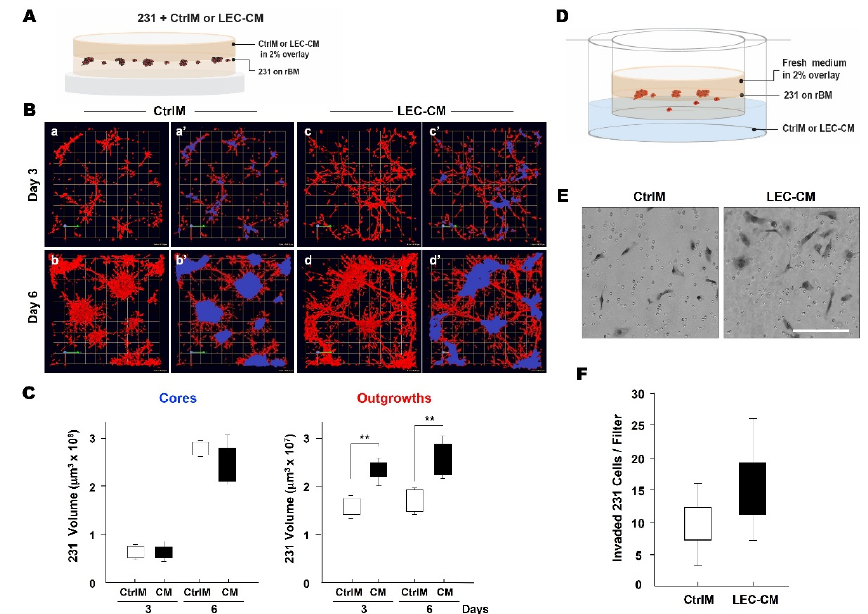
Figure 4. LEC secretome increases invasive phenotype of MDA-MB-231 spheroids. ( A ) Schematic illustrating protocol for incubation of 231 spheroids in 3D rBM overlay cultures with control media (CtrlM) or LEC MG -conditioned media (LEC-CM or CM). ( B ) En face views of representative 3D reconstructions of 231 spheroids (red) in CtrlM (a,b) or LEC-CM (c,d) at 3 and 6 days. To quantify effects on invasive phenotype, 231 spheroids were segmented as illustrated in a’–d’ into central cores (blue) and multicellular invasive outgrowths (red) using Volocity software. Images are tiled from 16 contiguous fields; each grid represents 250 µ m. ( C ) Volumes of 231 cores and multicellular invasive outgrowths at days 3 and 6 of incubation with CtrlM or LEC-CM (CM) were quantified with Volocity as previously described [70]; ** p ≤ 0.01. ( D ) Schematic of in vitro 3D invasion assay: 231 spheroids were cultured in the presence of control media (CtrlM) or LEC MG -conditioned media (LEC-CM). ( E ) DIC (differential interference contrast) images of invaded cells attached to the underside of the insert. Scale bar, 200 µ m. ( F ) Invasion of 231 cells from spheroids incubated in the presence of CtrlM or LEC-CM for 2 days was quantified with